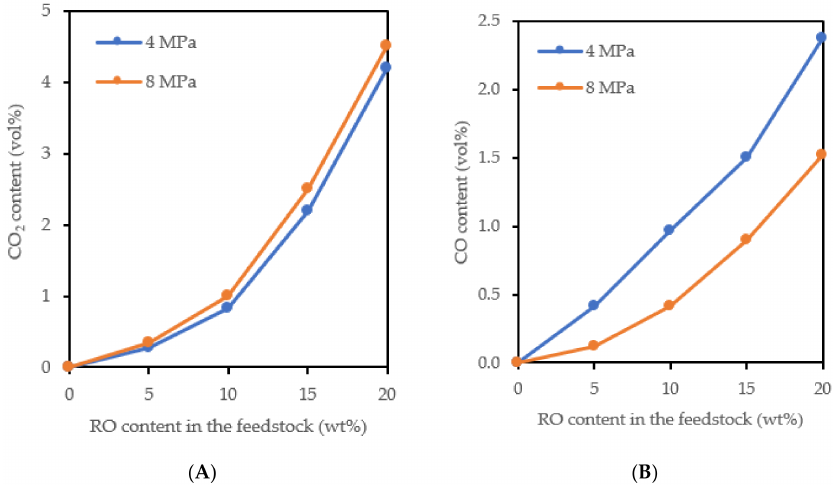
Figure 4. The content of CO 2 ( A ) and CO ( B ) in the gaseous hydrotreated products (pressure of 4 and 8